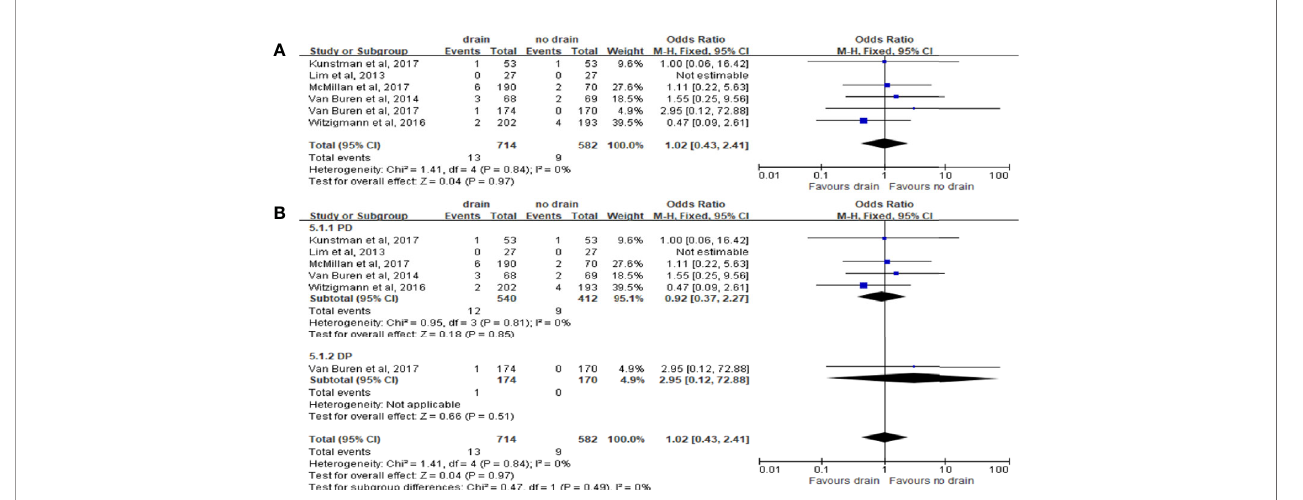
FIGURE 7 | Forest plot of the comparison of the rate of biliary fi stula in drain versus no-drain groups after pancreatic resection. (A) Comparison in overall; (B) comparison in PD and DP subgroups,